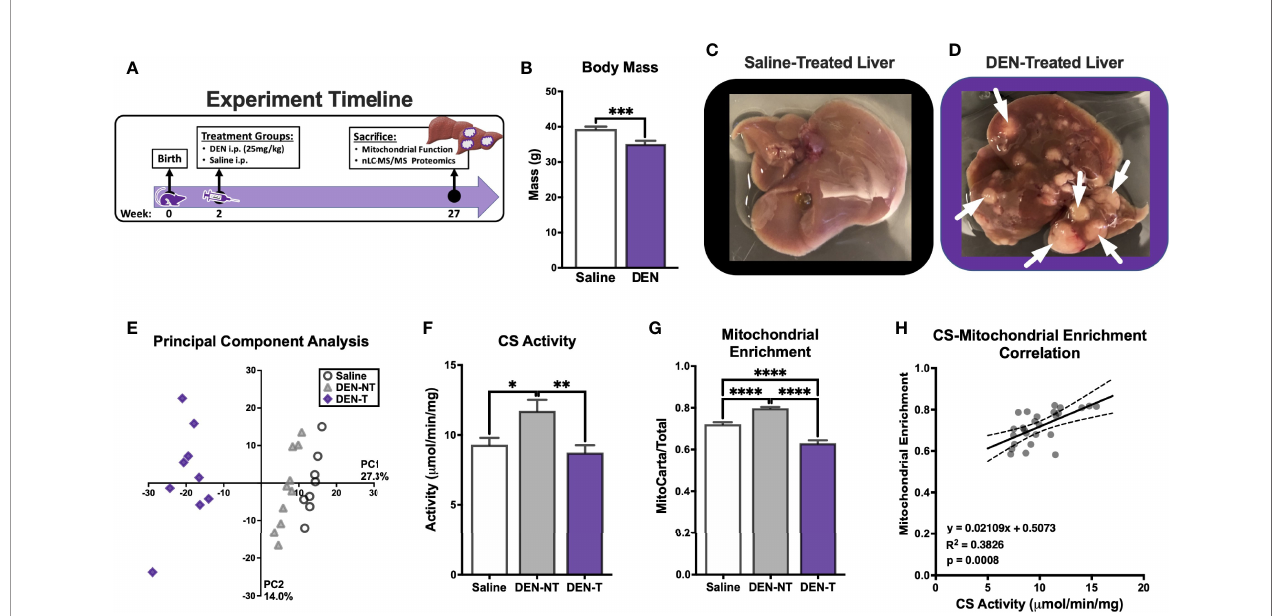
FIGURE 2 | Induction of hepatocellular carcinoma in C3H mice using diethylnitrosamine (DEN) and the purity of the resultant isolated mitochondrial preparations. (A) Experiment timeline of DEN treatment. (B) Body weight (g) of saline and DEN-treated mice at time of sacri fi ce. (C, D) Images of saline (C) and DEN-treated livers (D) ; white arrows denote tumors. (E) Principal component analysis (PCA) of isolated mitochondrial preparations from saline treated liver (Saline), DEN-treated nontumor (DEN-NT), and DEN-induced tumor (DEN-T). (F) Citrate synthase (CS) activity of isolated mitochondria. (G) Comparison of mitochondrial enrichment calculated of the ratio of mitochondrial (MitoCarta) to total protein abundance. (H) Linear correlation between CS activity and mitochondrial enrichment. Data are presented as mean ± SEM and analyzed by unpaired t-test (B) and one-way ANOVA (F, G) . *p < 0.05, **p < 0.01, ***p < 0.001, ****p <